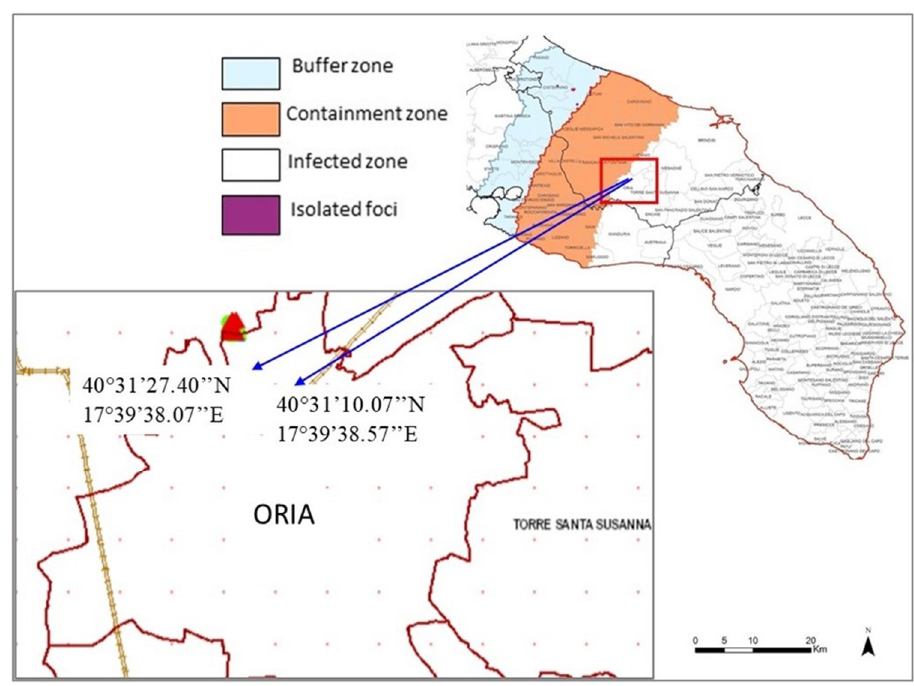
Figure 1. Experimental fields located at Oria (Apulia, province of Brindisi) on the edge between the infected and containment areas. The image was redrawn 01 October 2018 from https://www.emergenzaxylella.it.